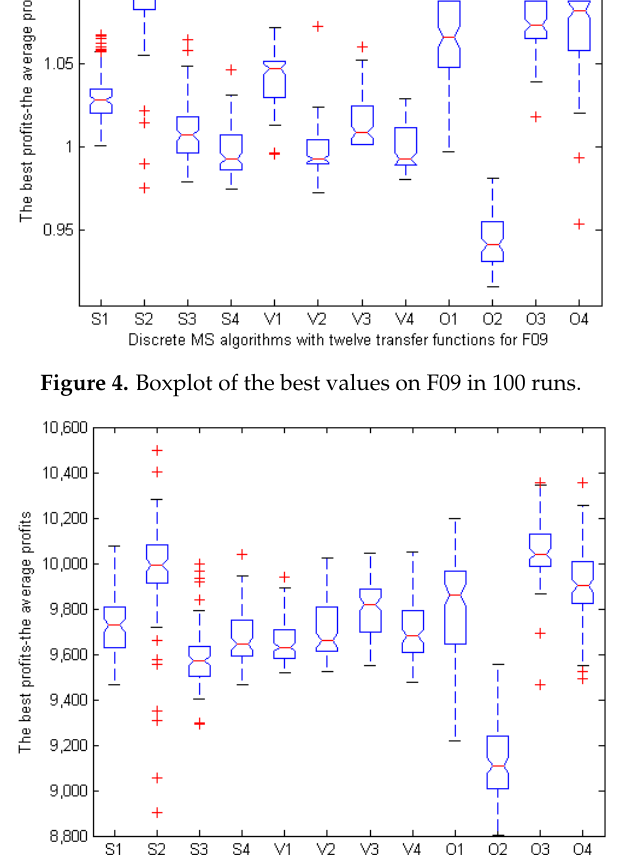
Figure 5. Boxplot of the best values on S09 in 100 runs.